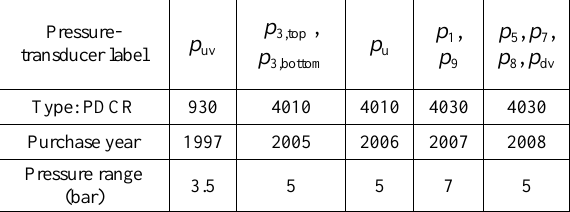
Table 1. Specifications of the pressure